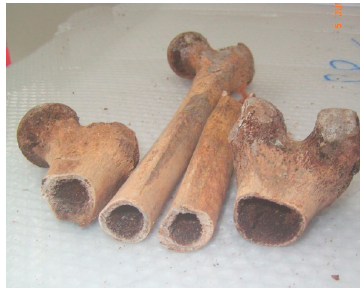
Figure A3. Transverse section of the two femurs. As reported in the text, two segments of the diaphysis were collected for genetic analysis. Note the brown residues of the trabecular part of the bone.